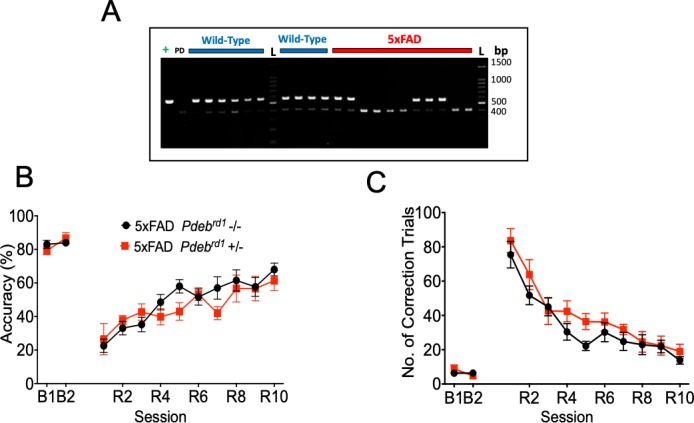
PDEBrd1 mutation effect in the behaviour of 5xFAD mice.(A) Representative genotyping results. 5xFAD mice (red) and WT controls (blue) were genotyped as described. In the first lane, there is a positive control (+) for the 550 bp Pdebrd1 mutant allele obtained from FVB/NJ mice, followed by a WT control for the 400 bp wild-type PDEB allele (WT). Ladder (L). (B) 10 months old 5xFADPdebrd1-/- and 5xFADPdebrd1+/- evaluated in the PVD task.